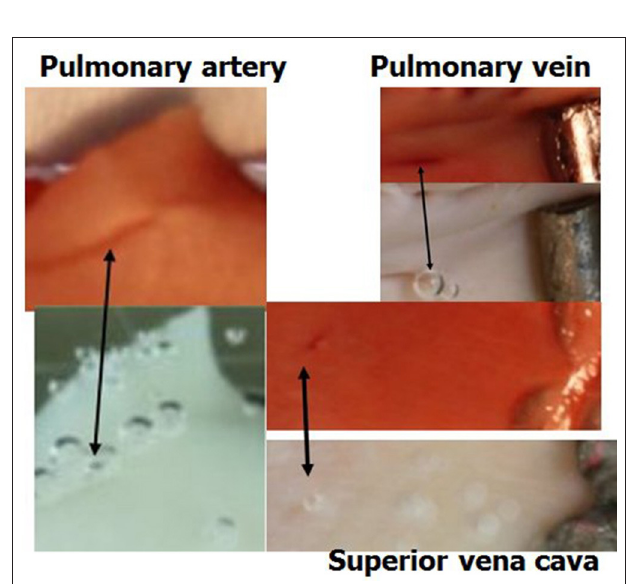
FIGURE 6 | Active spots are hydrophobic. Samples of blood vessels photographed under saline, revealing the AHS at which bubbles nucleate and expand. The same sample after staining for lipids (dark red) is presented above its previous presentation. Arrows indicate the bubbles on the AHS and the corresponding red staining for lipids.